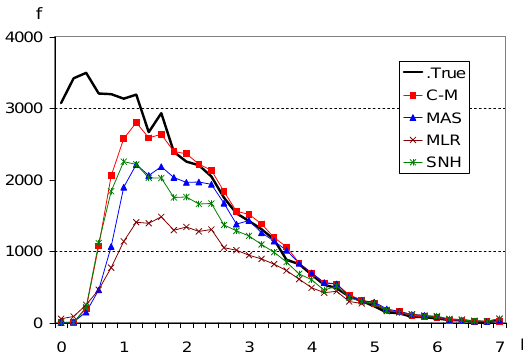
Figure 1. Magnitude-distribution of real and detected IHs (change- points) when the mean frequency of change-points is 5 per 100yr, and shift-magnitudes have normal distribution with 0 peak and 3.5 times larger standard deviation than s d . On the abscissa M means magnitude proportioned to s d , while frequencies ( f ) are shown with an arbitrary unit. Homogenisation methods: C-M – PRODIGE, MAS – Multiple Analysis of Series for Homogenization, MLR – Multiple Linear Regression, SNH – Standard Normal Homogeneity Test.